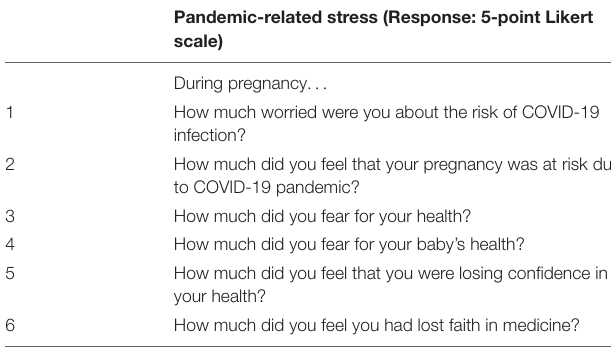
TABLE 2 | Positions of the selected BDNF CpG sites human genome assembly GRCh37 (hg19). CpG site #